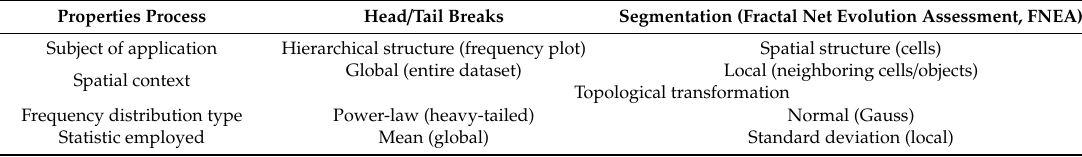
Table 1. Overview of the main processes in the new